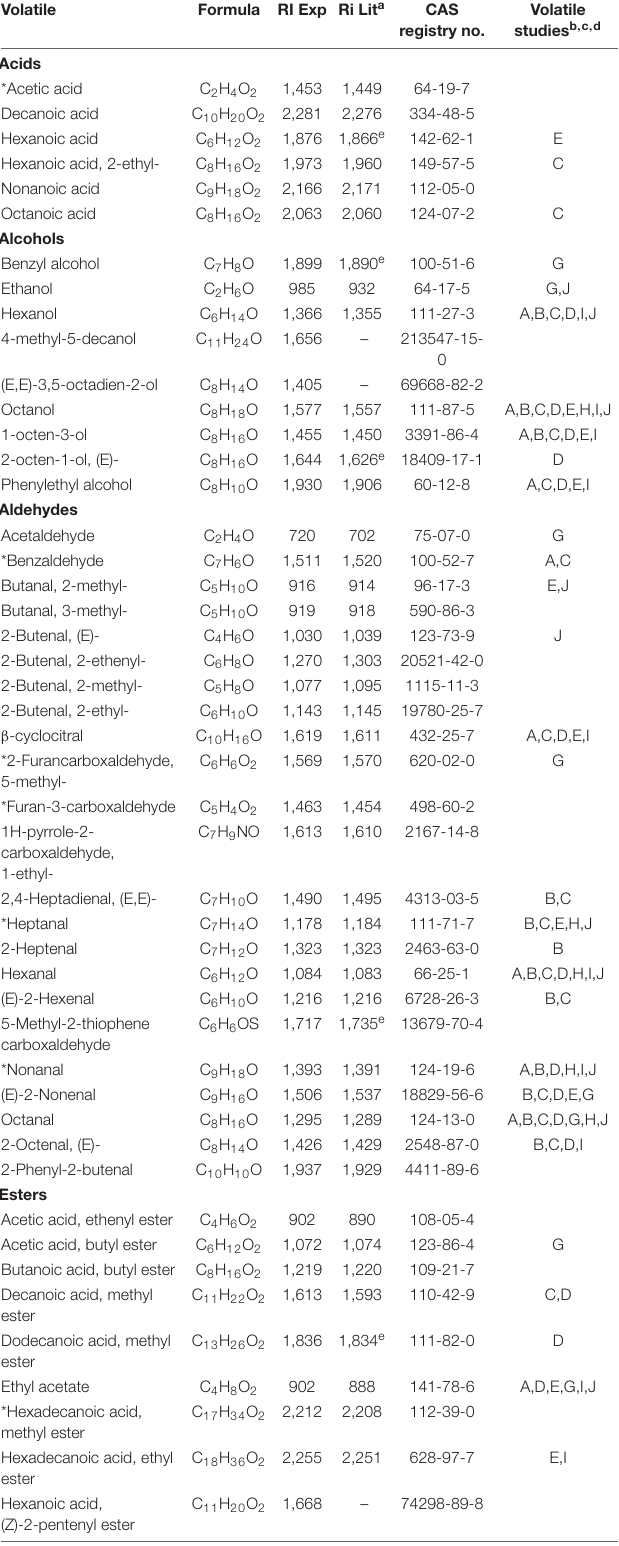
TABLE 1 | Date palm fruit volatiles identified by SPME/GC-MS and included in the present study.